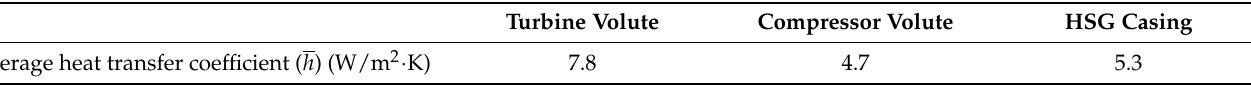
Table 5. MGT external wall free convection heat transfer coefficient calculations.